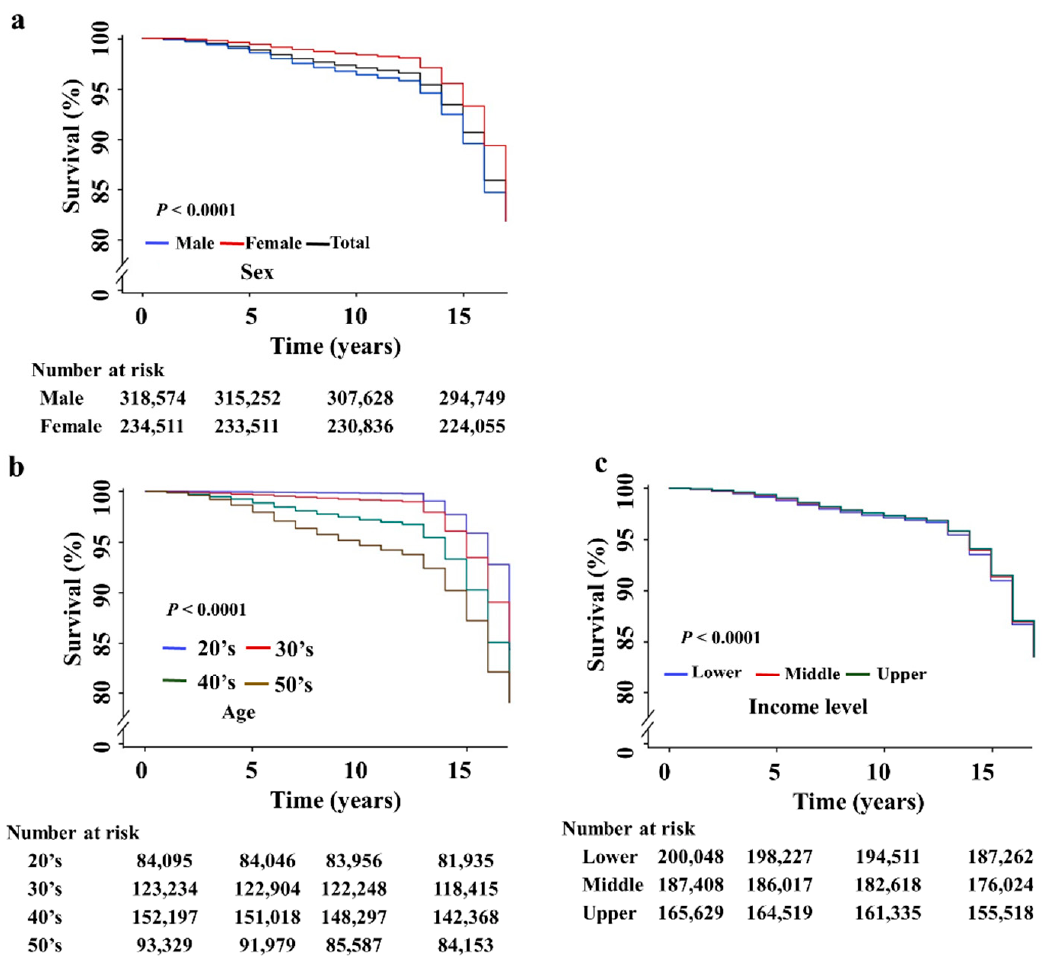
Figure 3. Survival rates of linked-to-care CHB patients according to ( a ) sex, ( b ) age, and ( c ) income level. All the p -values were less than 0.0001 in the comparison between 20 ′ s vs. 30 ′ s, 20 ′ s vs. 40 ′ s, 20 ′ s vs. 50s, 30 ′ s vs. 40 ′ s, 30 ′ s vs. 50 ′ s, and 40 ′ s vs. 50 ′ s.